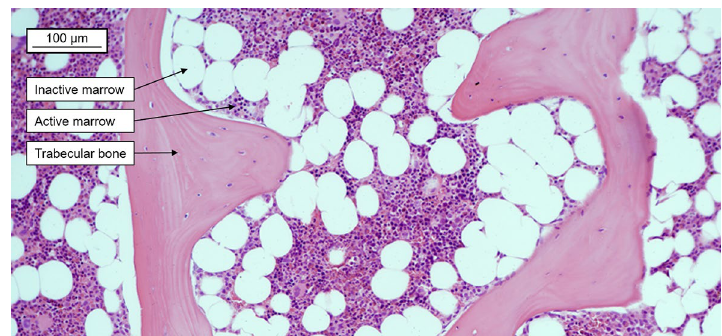
Fig. 1 Healthy lumbar spongiosa biopsy from a 65-year-old male showing active and inactive marrow and trabecular bone